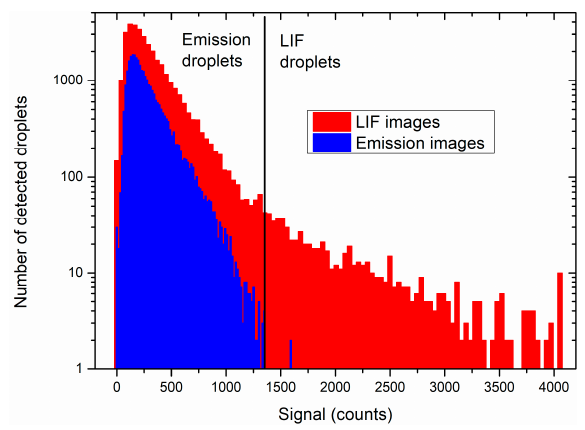
Figure 7. Signal distribution of the droplets detected by the MSER algorithm in the LIF and emission images.